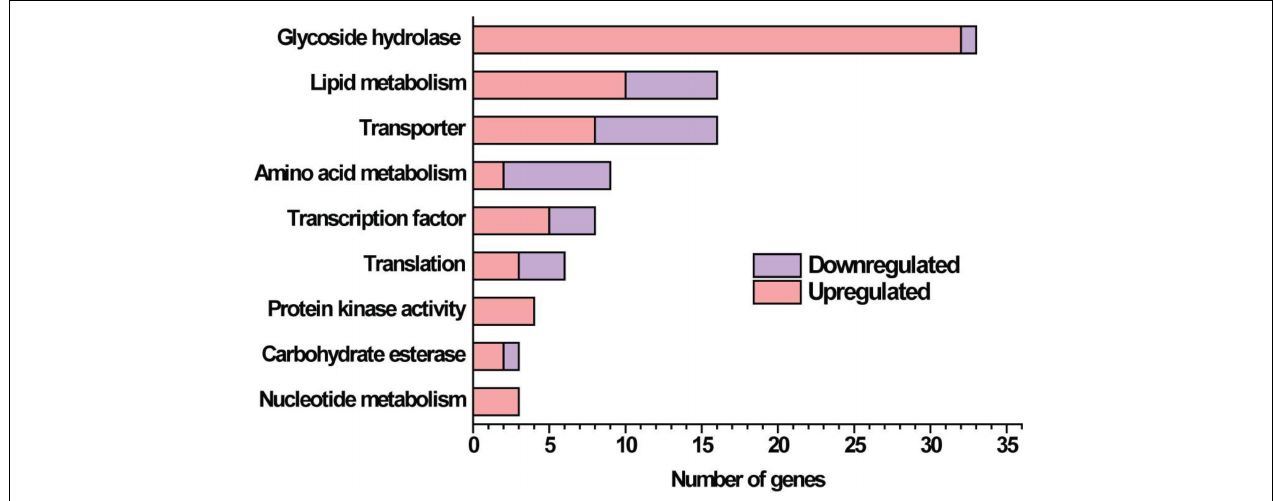
FIGURE 6 | Functional category of differentially expressed genes in (cid:49) gat1 compared with QM9414. Transcriptome analysis identified a total of 255 differentially expressed genes between (cid:49) gat1 and QM9414. The 130 genes that encode hypothetical proteins and 27 unclassified proteins are not included in this